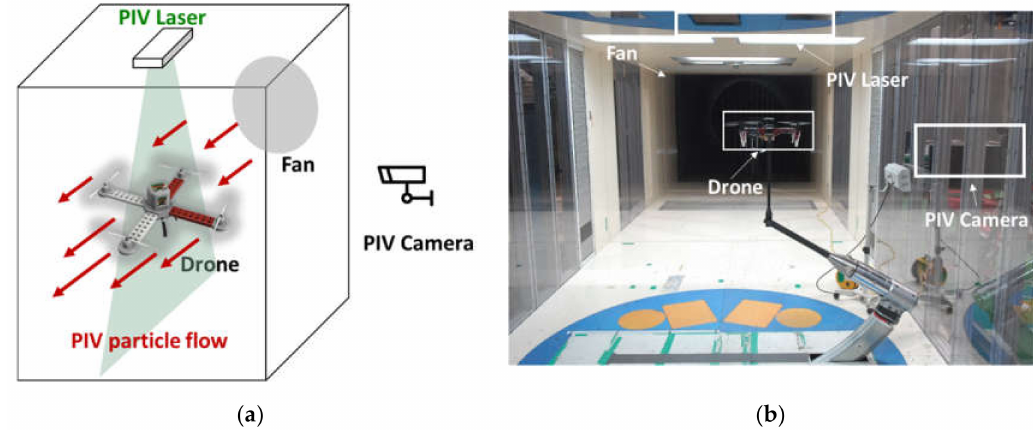
Figure 4. PIV experiment setup: ( a ) illustration of the observation of the aerodynamics near the UAV, and ( b ) photograph of the actual experiment